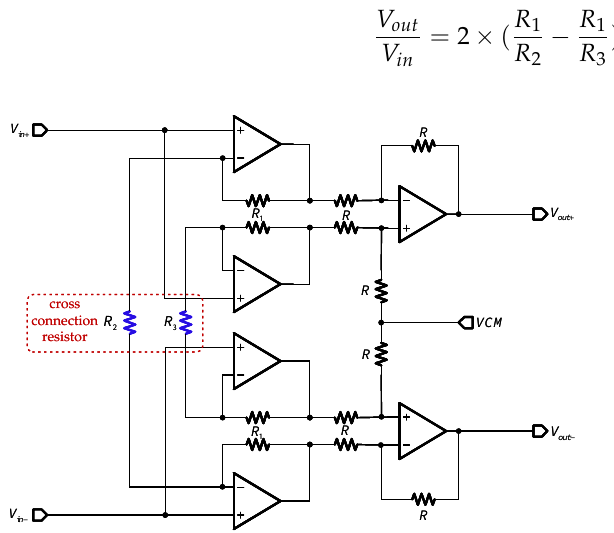
Figure 12. The schematic of the low noise